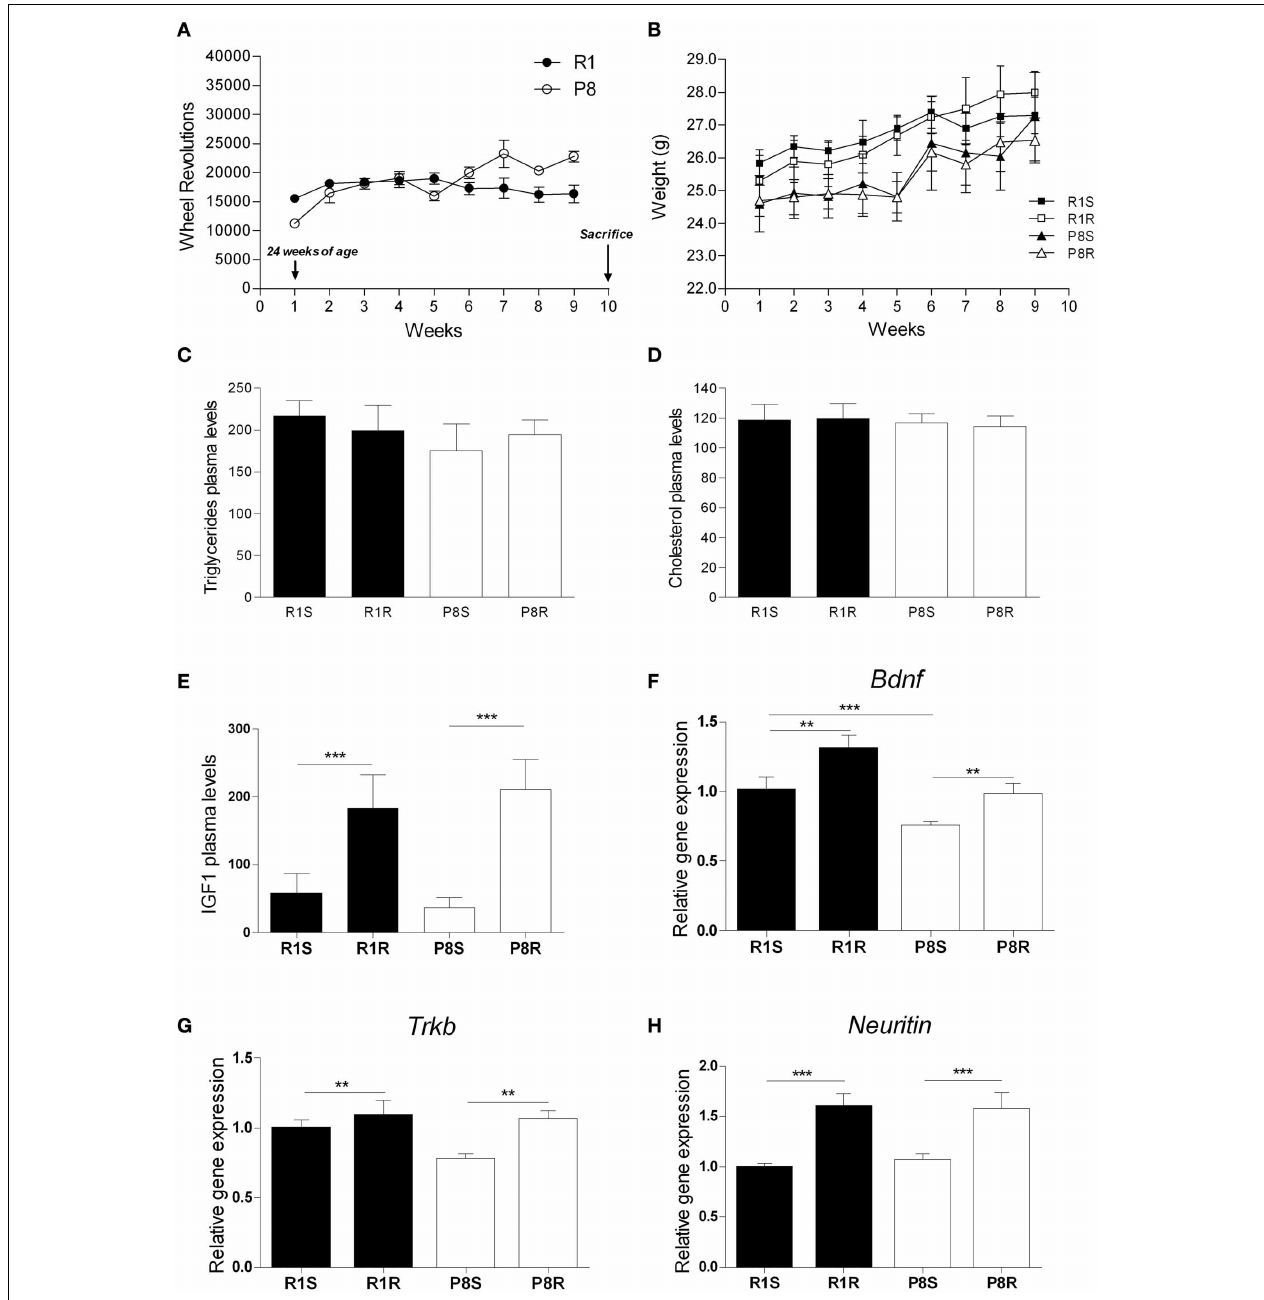
FIGURE 1 | Beneficial effects of 8 weeks of exercise training in SAMP8 senescent mice. ( A ) Mean wheel revolutions/week register in exercised SAMR1 and SAMP8 mice; (B) Body weight (g) mean during exercise intervention in sedentary and exercised groups from both SAMR1 and SAMP8 strains. (C) Triglyceride plasma levels (mg/dL). (D) Cholesterol plasma levels (mg/dL). (E) IGF1 plasma levels (ng/mL). (F–H)